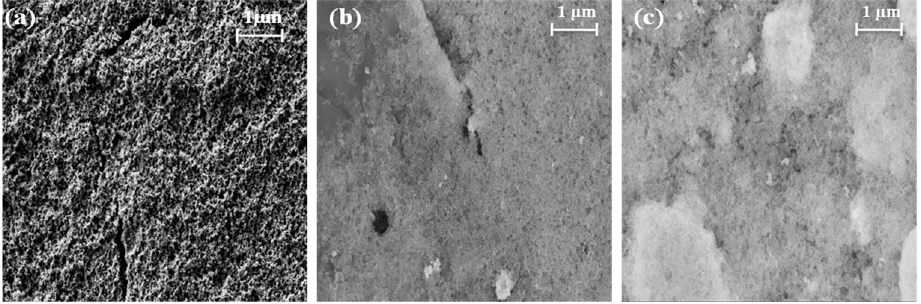
Figure 5. SEM images of the ( a ) Pt/C, ( b ) Pt/C:CTFO 1:0.5, and ( c ) Pt/C:CTFO 1:1 mixture at 50 k× magnification.